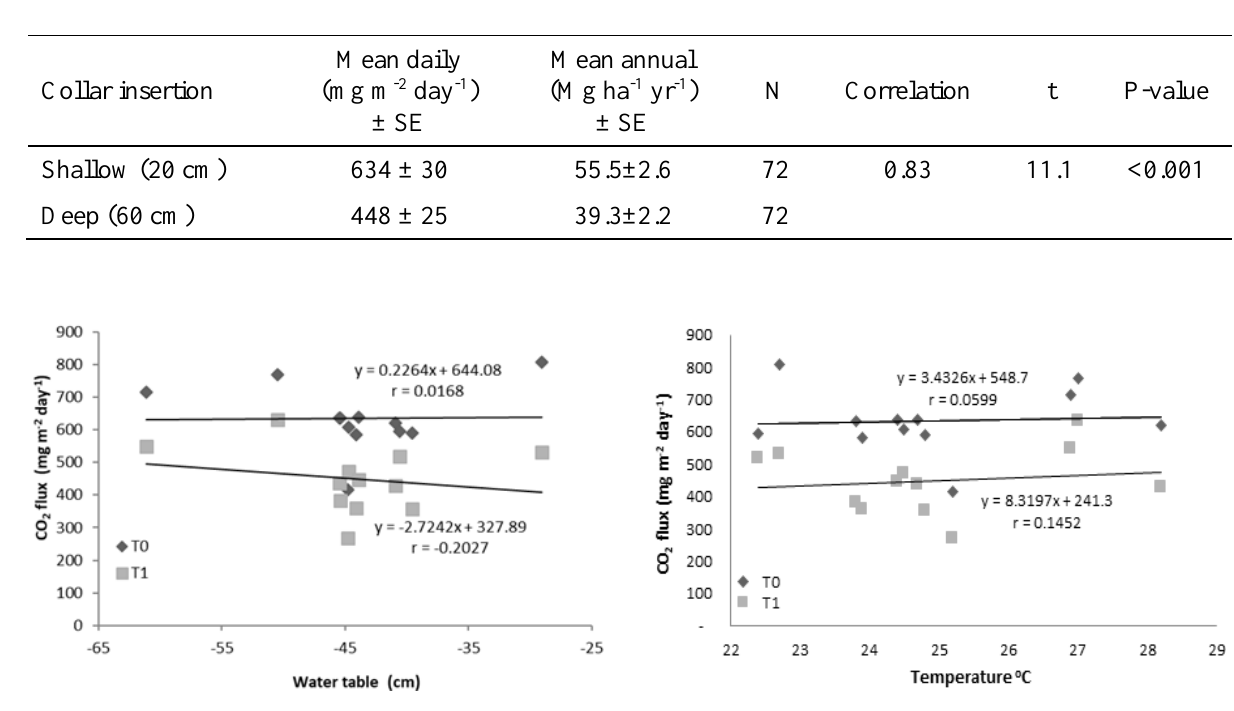
Table 2. Paired sample t test of carbon dioxide (CO 2 ) emissions (Mg ha -1 yr -1 ) from the shallow and the deep collars. SE = standard error.